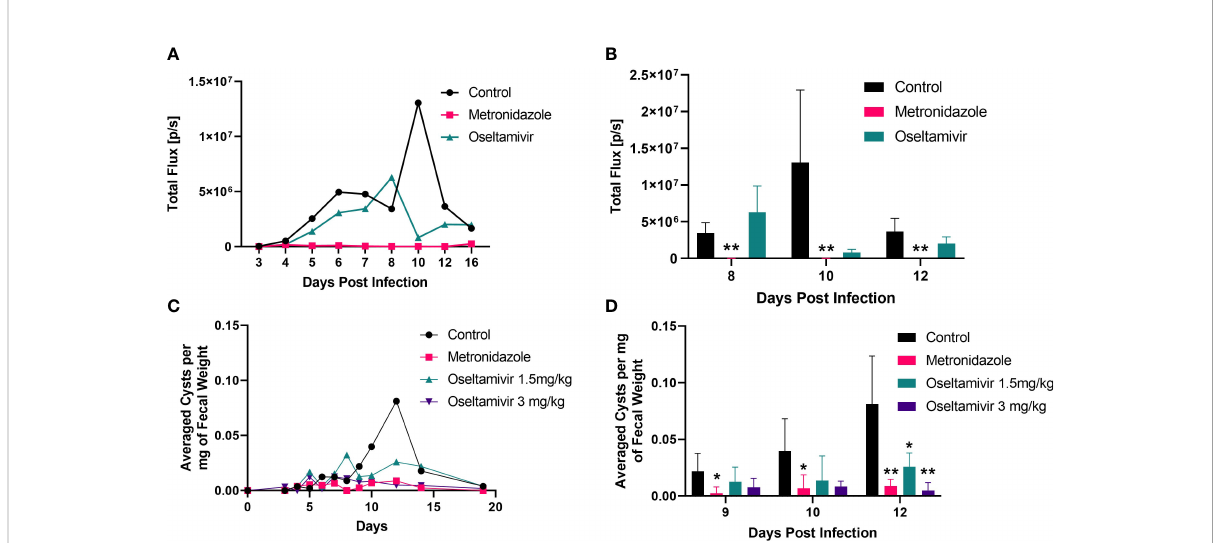
FIGURE 10 Inhibition of Giardia infection by oseltamivir in laboratory mice. Three to four-week-old mice (C57BL/6) were infected with luciferase- expressing trophozoites as detailed in Materials and Methods and tracked for colonization in the intestine followed by counting cysts in feces. (A) The treatment was initiated with oseltamivir (1.5 mg/kg) after 48 h of infection. Metronidazole (3.0 mg/kg) was used as a positive control. Bioluminescent signals from mice intestine (5 per group) were imaged through IVIS Lumina III In Vivo Imaging System (Perkin Elmer) to track the colonization (expressed total fl ux) are shown. (B) Statistical analysis of the bioluminescent experiments shown in Panel (A, C) Cyst counts in feces belonging to four different group of mice: control, metronidazole 3mg/kg, and oseltamivir at 1.5 mg/kg and 3mg/kg. Fecal counts were normalized by dividing the total amount of cysts identi fi ed to the total fecal weight collected. (D) Statistical signi fi cance of the reduction in fecal excretion of Giardia cysts by nystatin and oseltamivir. A total of fi ve mice were used between each group. Nonparametric T-test was conducted on peak days of infection. *p < 0.05, **p <